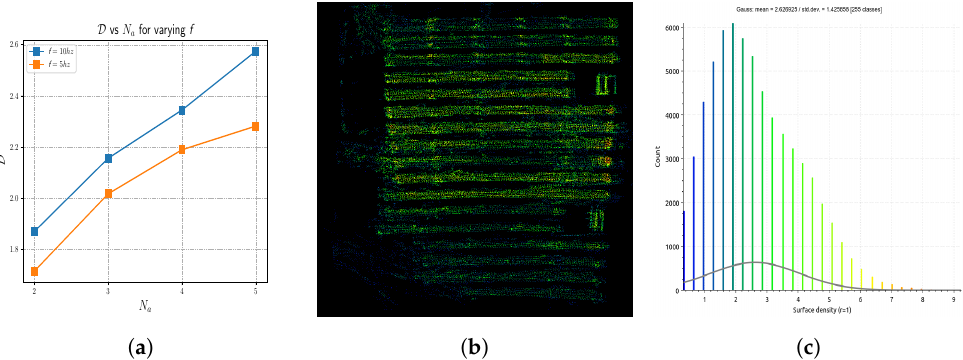
Figure 11. ( a ) The variation of mean density of merged map over N a across different rates, ( b ) the surface density distribution across the point cloud in Figure 8a, ( c ) The histogram of surface density distribution for the point cloud in Figure